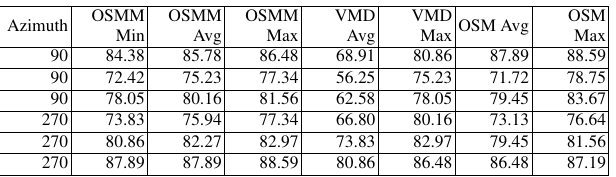
Table 6: Variation in Elevation Across the Three Data Sources East/West Across the Street - Fenchurch Buildings